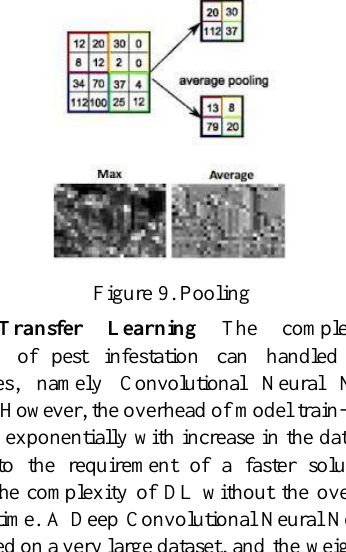
Figure 7. Convolutional Neural Network